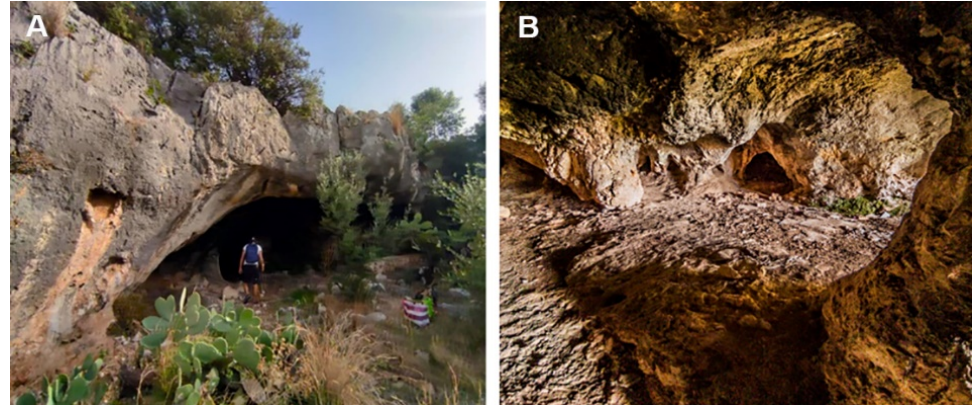
Figure 17. ( A ) Entrance of the Tremilia Cave. ( B ) Sector of the cave at the entrance better preserving the shell-rich deposit.